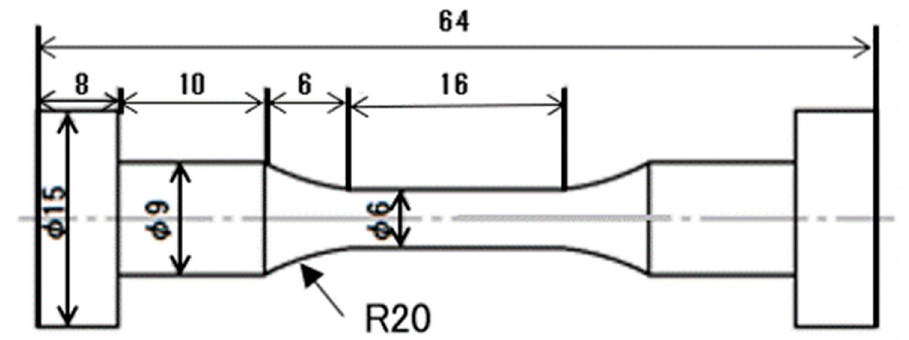
Figure 1. Schematic of the tensile test specimen (unit: mm), adapted from [25].